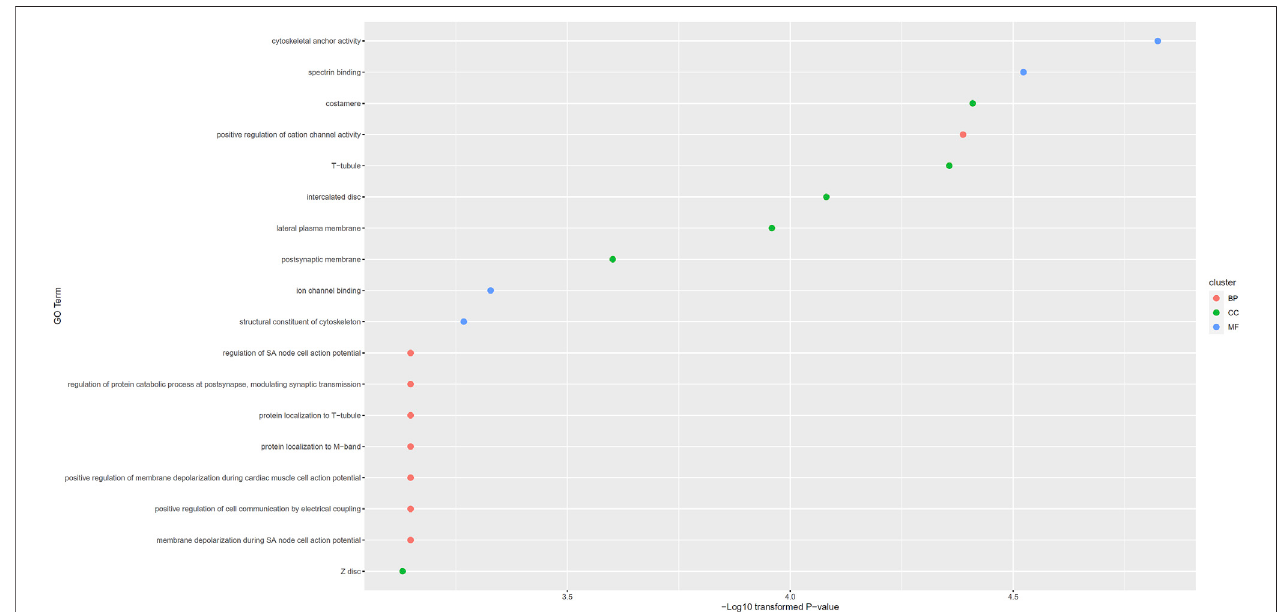
FIGURE 4 | Gene ontology (GO) enrichment results for putative genes associated with congenital deafness. GO terms with p -value less than 0.001 are selected and ranked by their p -values.